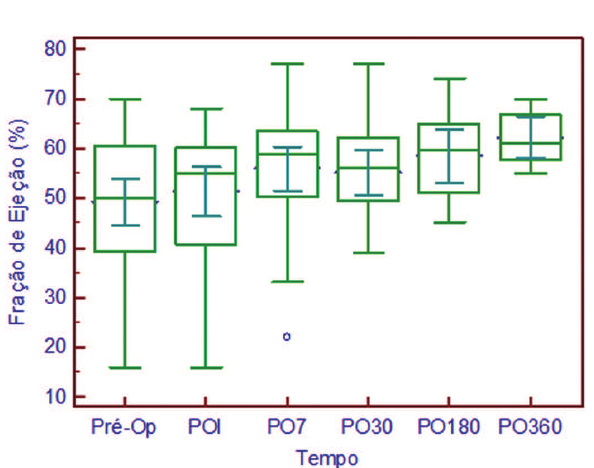
Fig. 5 – Fração de ejeção do ventrículo esquerdo no pré, 1º, 7º, 30º, 180º, 360º pós-operatório. Pré-operatório versus 1º pós-operatório – P>0,05 Pré-operatório versus 7º pós-operatório – P=0,01 Pré-operatório versus 30º pós-operatório –